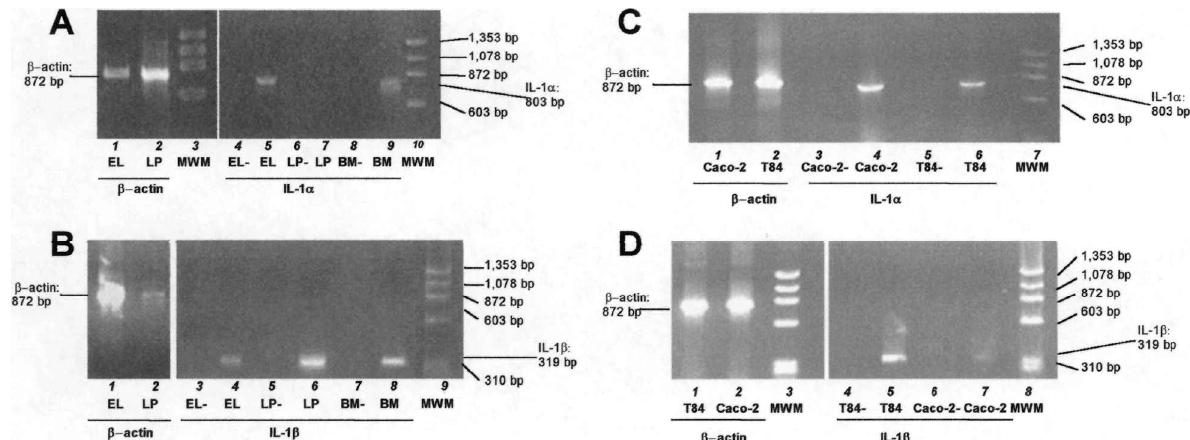
FIG. 1. Detection of (A, C) IL-1 a mRNA and (B, D) IL-1 b mRNA in (A, B) freshly isolated human small intestinal (ileal) specimens and (C, D) human colonic EC lines by RT-PCR. (A) Lanes 1 and 2, b -actin in the EL and LP from the same patient; lane 3, molecular weight marker (MWM); lane 4, negative control for lane 5 (no reverse transcriptase added to RNA during reverse transcription stage); lane 5, EL IL-1 a ; lane 6, negative control for lane 7; lane 7, lack of IL-1 a in LP; lane 8, negative control for lane 9; lane 9, BM IL-1 a ; lane 10, MWM. (B) Lanes 1 and 2, b -actin in EL and LP from the same patient; lane 3, negative control for lane 4; lane 4, EL IL-1 b ; lane 5, negative control for lane 6; lane 6, IL-1 b in LP; lane 7, negative control for lane 8; lane 8, BM IL-1 b ; lane 9, MWM. (C) Lanes 1 and 2, Caco-2 and T84 b -actin; lane 3, negative control for lane 4; lane 4, Caco-2 IL-1 a ; lane 5, negative control for lane 6; lane 6, T84 IL-1 a ; lane 7, MWM. (D) Lanes 1 and 2, T84 and Caco-2 b -actin; lane 3, MWM; lane 4, negative control for lane 5; lane 5, T84 IL-1 b ; lane 6, negative control for lane 7; lane 7, Caco-2 IL-1 b mRNA; lane 8, MWM. Bp, base